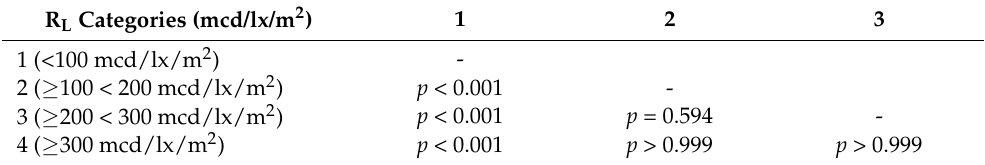
Table 5. Summary of difference in average range of view between categories of average R L